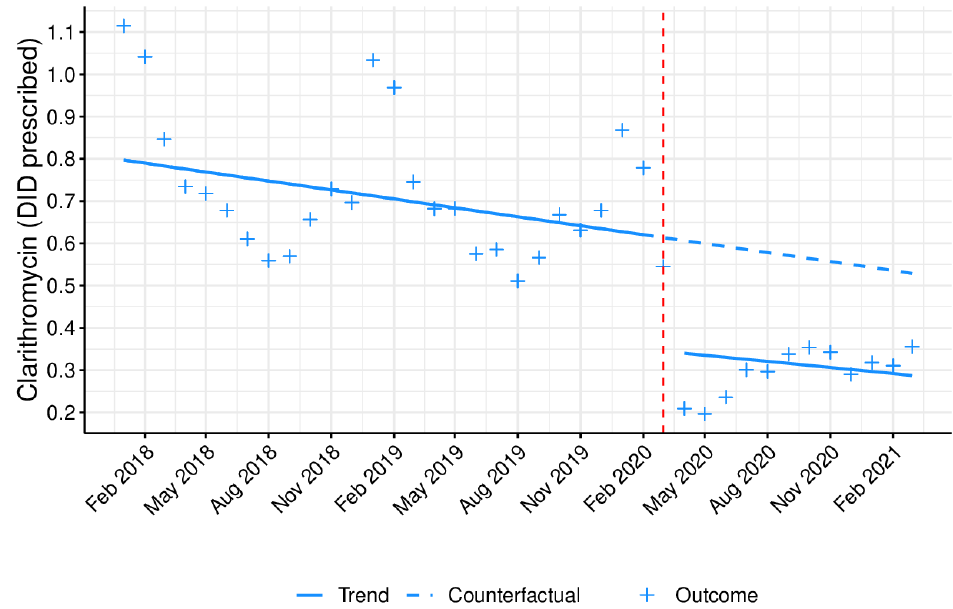
Figure 6. Monthly prescribing trend of clarithromycin as DID prescribed in outpatient care. Blue line ( − ): tendency line, after model adjustment; blue dashed line: expected tendency line with no COVID-19 emergence; red dashed line: COVID-19 emergence (March 2020); + : antibiotic monthly prescription in DID.